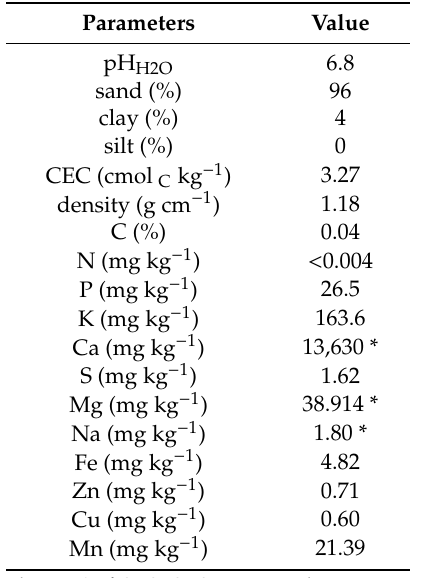
Table 4. Main parameters of the used